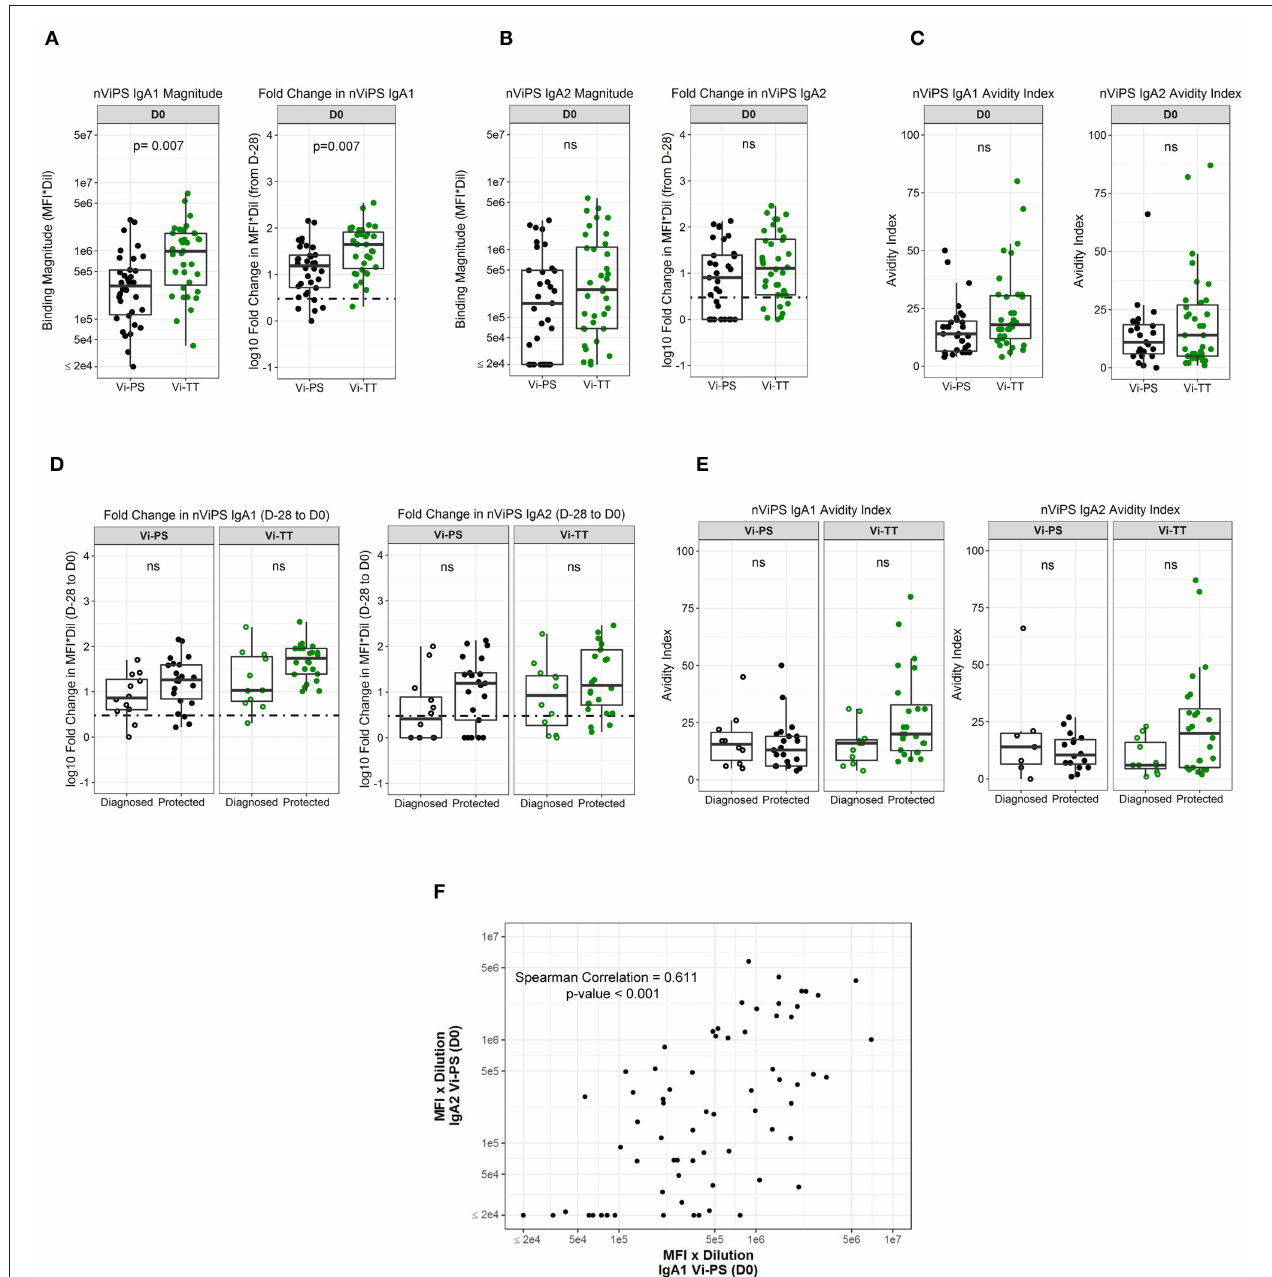
FIGURE 4 | nViPS IgA1 and IgA2 fold change higher in protected individuals in both vaccine groups. nViPS-specific IgA1 magnitude and fold change (A) and nViPS-specific IgA2 magnitude and fold change (B) by vaccine group from baseline to day of challenge. nViPS IgA1 and IgA2 avidity index (C) by vaccine group at day of challenge. IgA1 and IgA2 fold change from baseline to day of challenge by protected/diagnosed status (D) and IgA1 and IgA2 avidity index at day of challenge (E) by protected/diagnosed status. Data points are representative of n = 2 independent experiments (each with n = 2 technical replicates). Spearman correlation between nViPS IgA1 and IgA2 magnitude (F) at day of challenge. n.s indicates non-significant FDR-corrected p values.